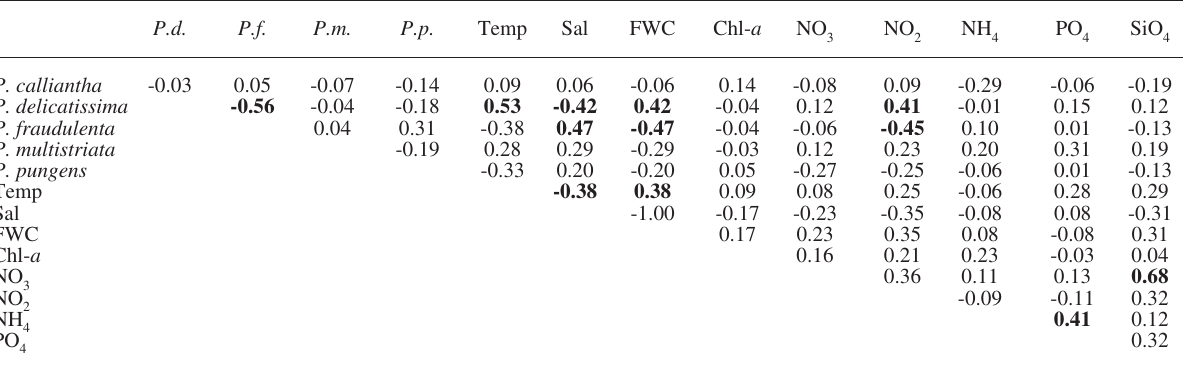
Table 6. – Spearman correlations between abiotic variables and Pseudo-nitzschia spp . abundances. Bold correlations are significant at p<0.01. P.d., P. delicatissima; P.f., P. fraudulenta; P.m., P. multistriata; P.p., P. pungens. P.d.